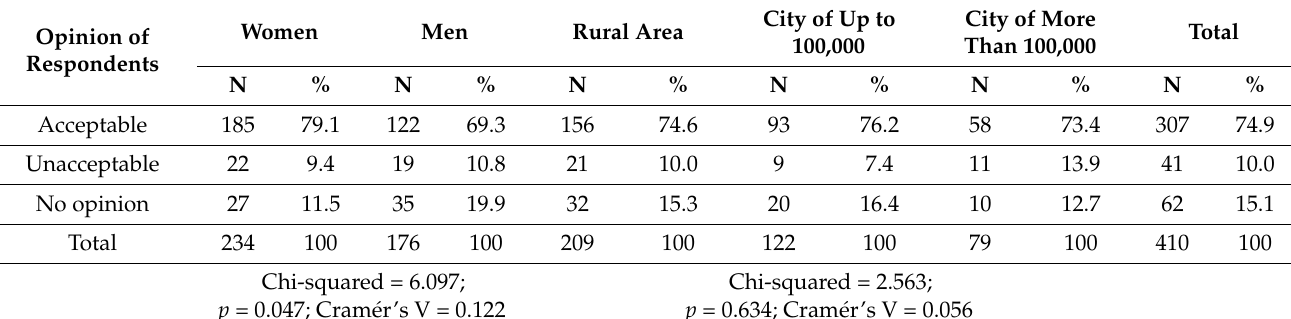
Table 4. Opinions on the use of